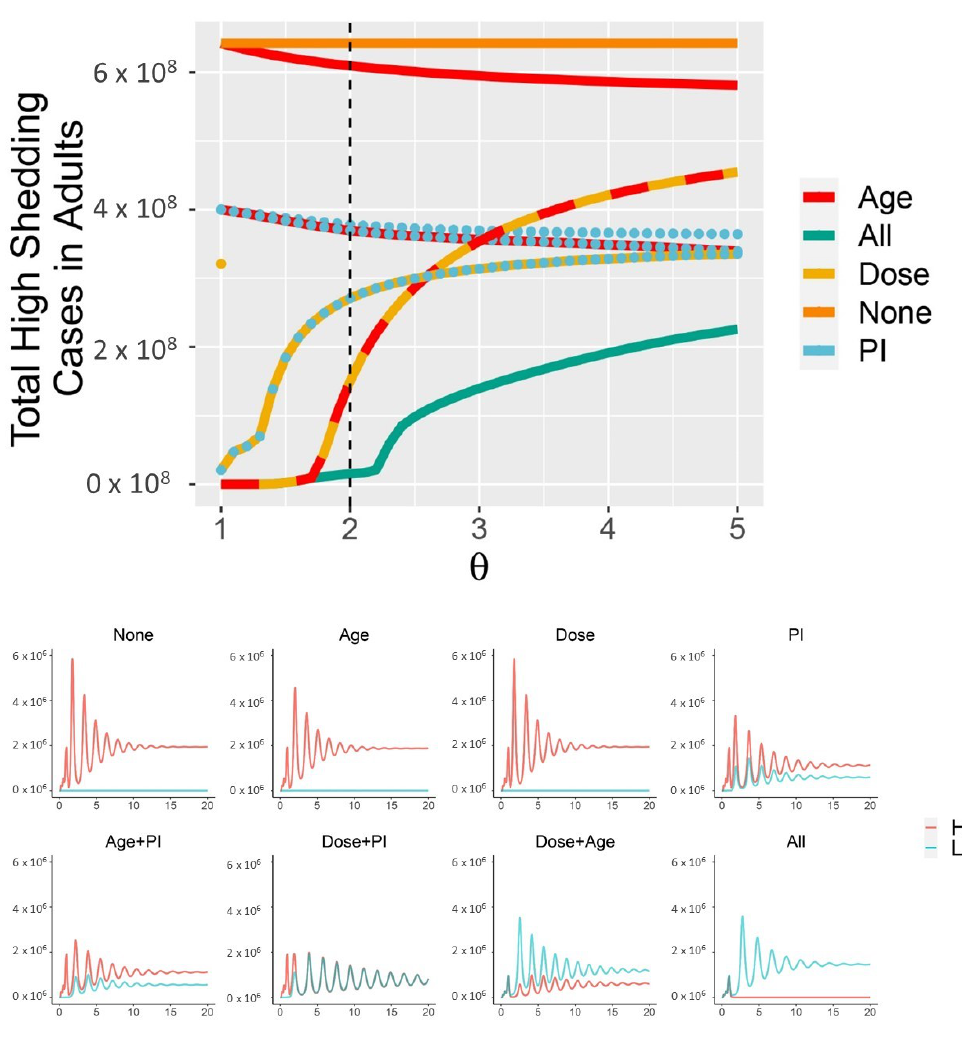
Figure 4. Dose response, partial immunity, and protective effects of youth combine to limit the cumulative number of high-shedding infections which occur within the first 30 years ( top panel ). “Dose” in isolation is identical to “None” for θ > 1. Each combination of the three mechanisms produces different dynamics, as shown for θ = 2 ( bottom panel , which corresponds to dotted black line in the top panel ). High-shedding cases are driven close to extinction only if all three mechanisms are in place (“All mechanisms” in ( bottom panel )). Cases are shown within adults only. Across all simulations, ν k = 1/2, Ω = 3 × 10 6 /day. In the “All” curves, Q ab = 0, and the other Q xy , (cid:103) Q xy = 1. In the “None” curves, Q xy = (cid:103) Q xy = 0. Curves with the “Age” mechanism have Q ky = (cid:103) Q ky = 1. Curves with the “Dose” mechanism have Q xl = (cid:103) Q xl = 1, and “Dose only” additionally has Q xh = (cid:103) Q xh = 0 (partial immunity and Age override this latter constraint). Curves with the “PI” mechanism have (cid:103) Q xy =